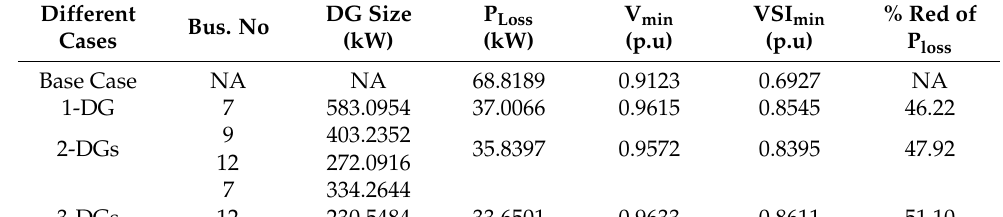
Figure 8. 28 Indian real test system single line diagram.